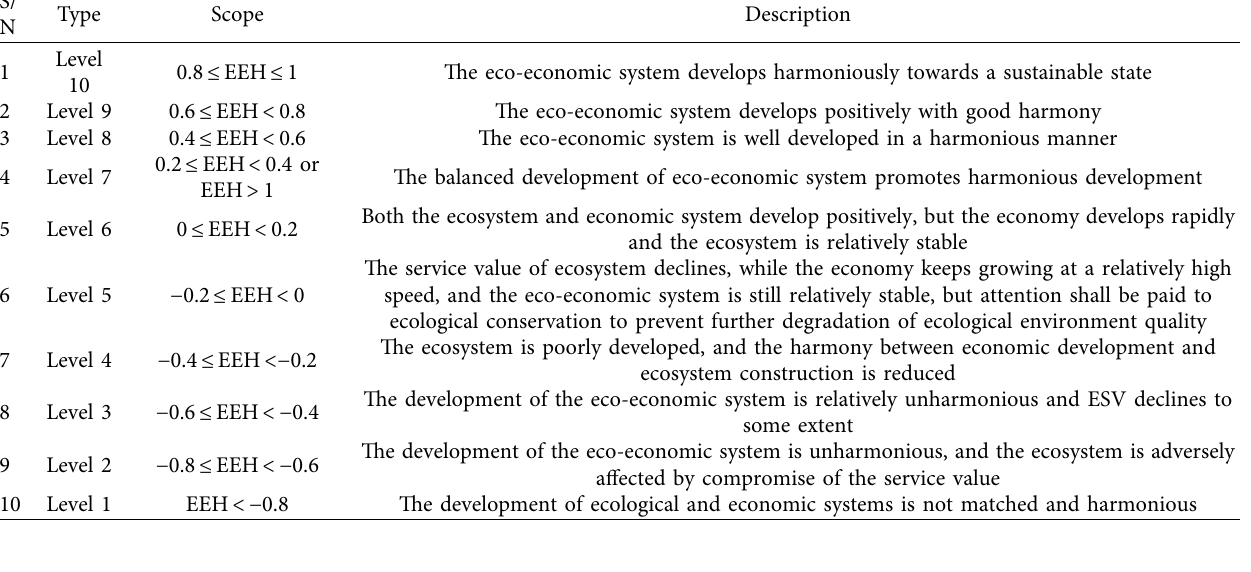
Table 2: Classification criteria of ecological-economic system harmony.